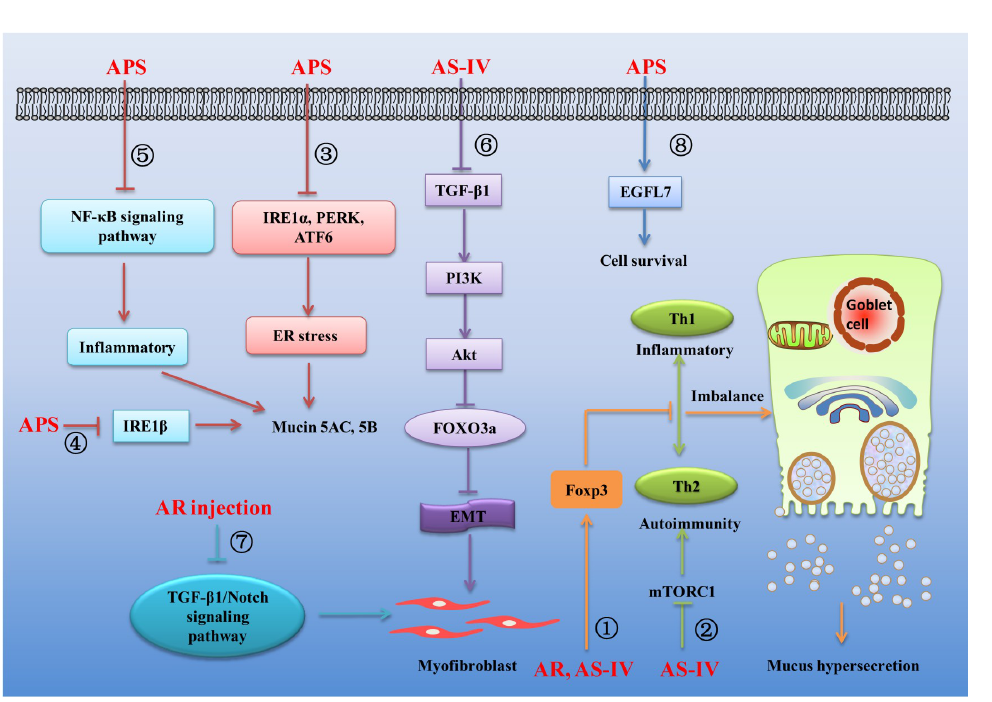
Figure 5. Several mechanisms linking AR and its main components to the treatment of respiratory diseases. Arrows and bar-headed lines represent signaling activation and inhibition, respectively. The different signaling pathways regulated by AR and its components are numbered ① to ⑧ .